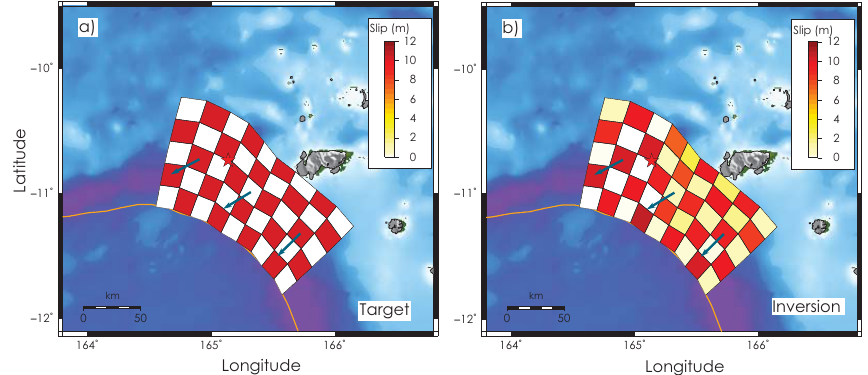
Figure 3. Resolution test: (a) target slip and rake (blue arrows) pattern; (b) slip model obtained by inverting tsunami data.